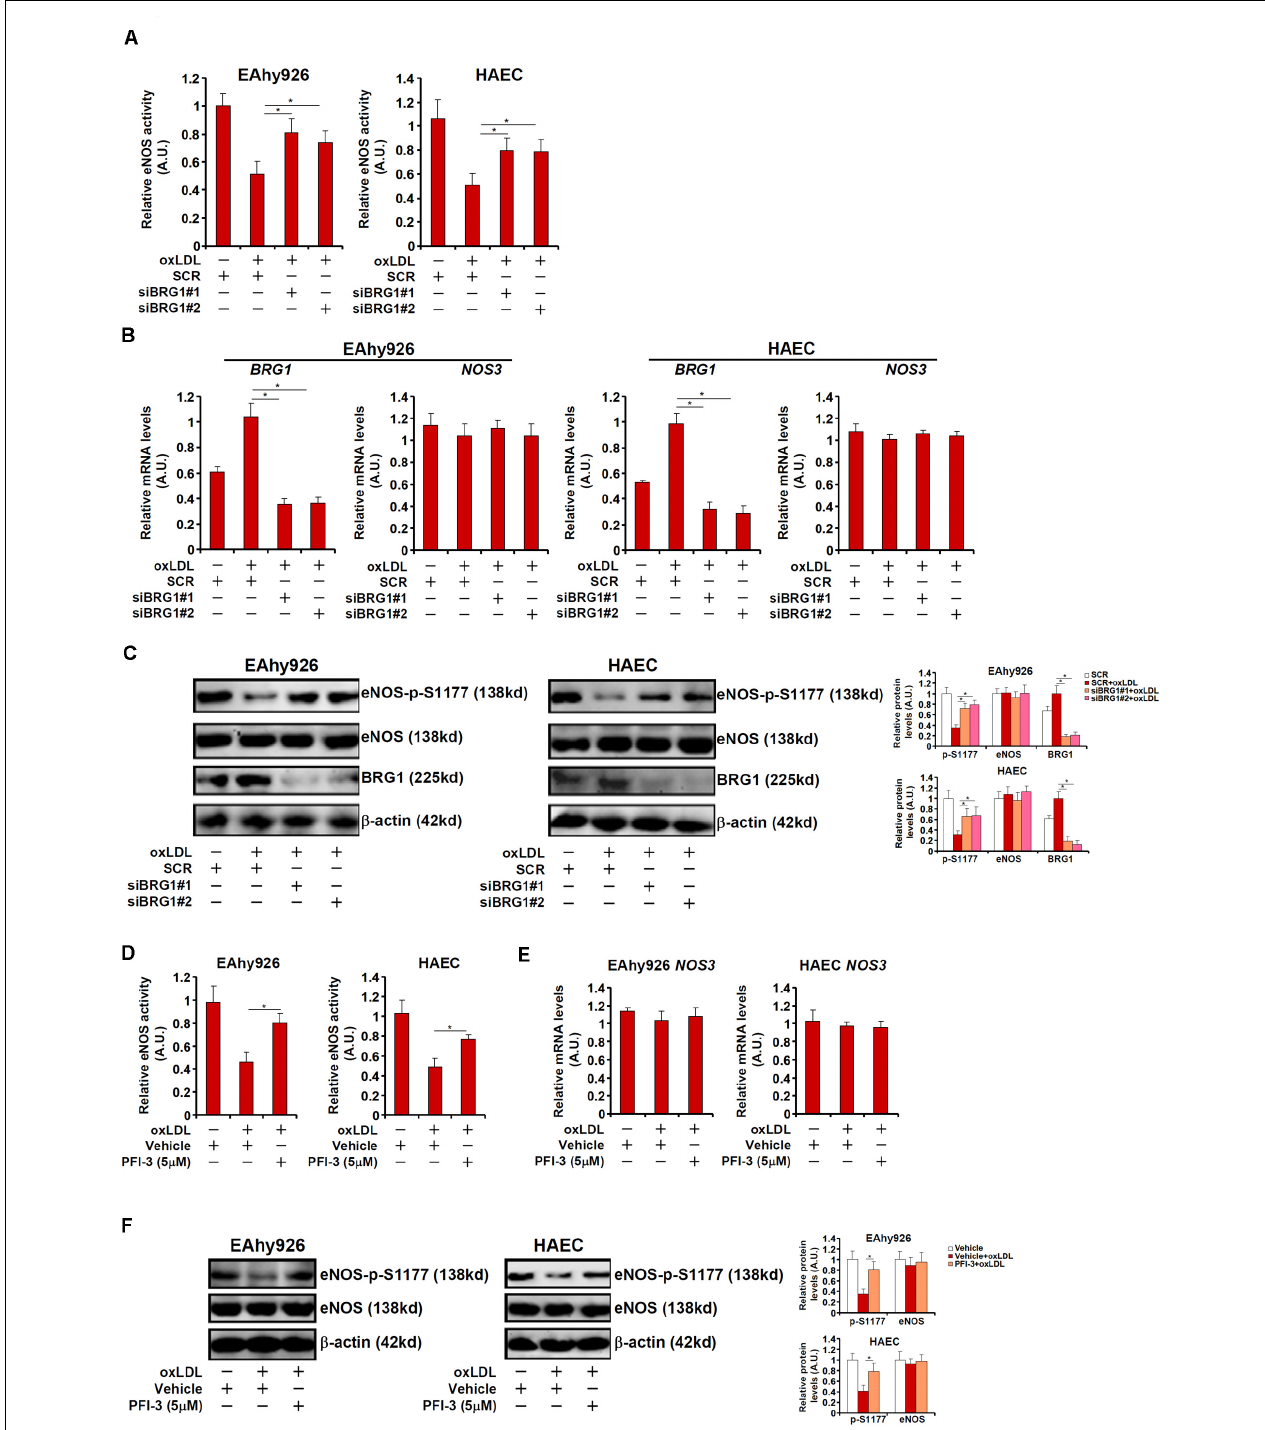
FIGURE 2 | BRG1 regulates NO bioavailability by modulating eNOS phosphorylation in cultured endothelial cells. (A–C) EAhy926 cells and HAECs were transfected with siRNA targeting BRG1 or scrambled siRNA (SCR) followed by treatment with oxLDL (10 µ g/ml) for 24 h. NO content in the culture media was examined by the Griess assay. Gene expression levels were examined by qPCR and Western. (D–F) EAhy926 cells and HAECs were treated with oxLDL (10 µ g/ml) in the presence or absence of PFI-3 (5 µ M) for 24 h. NO content in the culture media was examined by the Griess assay. Gene expression levels were examined by qPCR and Western. * p <